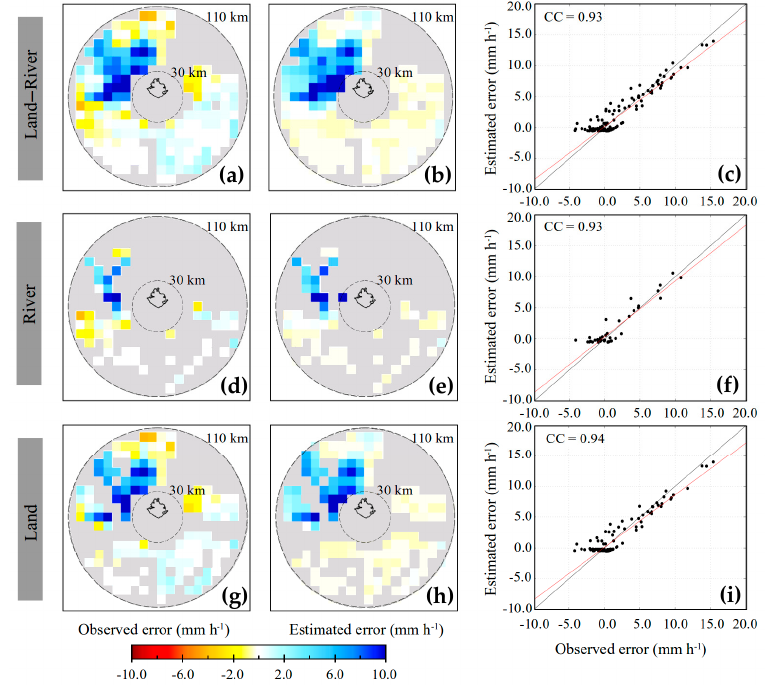
Figure 6. As in Figure 5, but for the wet validation period (04:00–04:29 UTC on 12 March 2014). Remote Sens. 2018 , 10 , x FOR PEER REVIEW